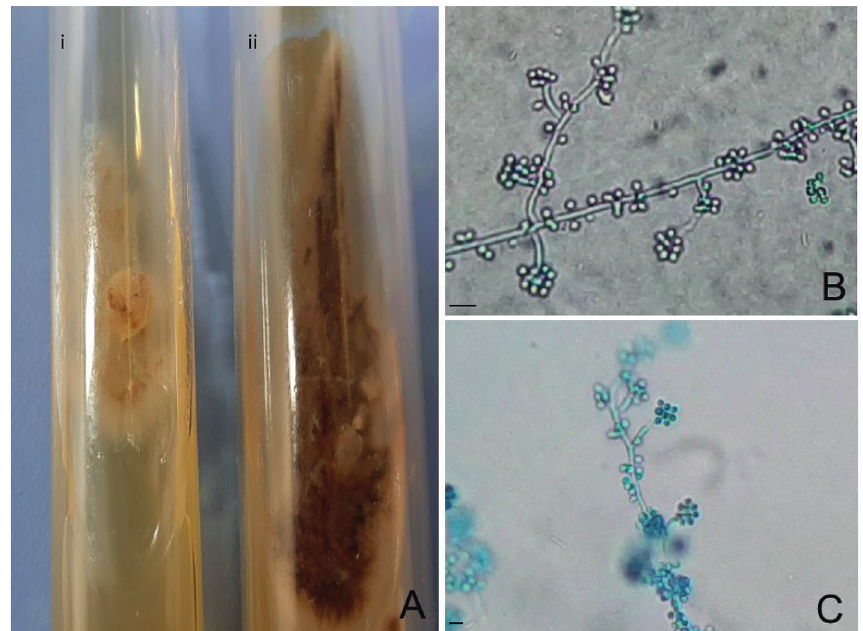
Figure 2: Skin samples were cultured in an agar-dextrose Sabouraud medium. (a) (i) In the sample cultured at 37 ° C, the fungi presented whitish/yellowish color with leveduriform aspect, and (ii) at 25 ° C, the fungi presented a brownish color that corresponded to the filamentous form of (b) fungi with conidiophore bouquet-like structures (c), magnification of 400x and 200x, respectively. Bars � 5 μ